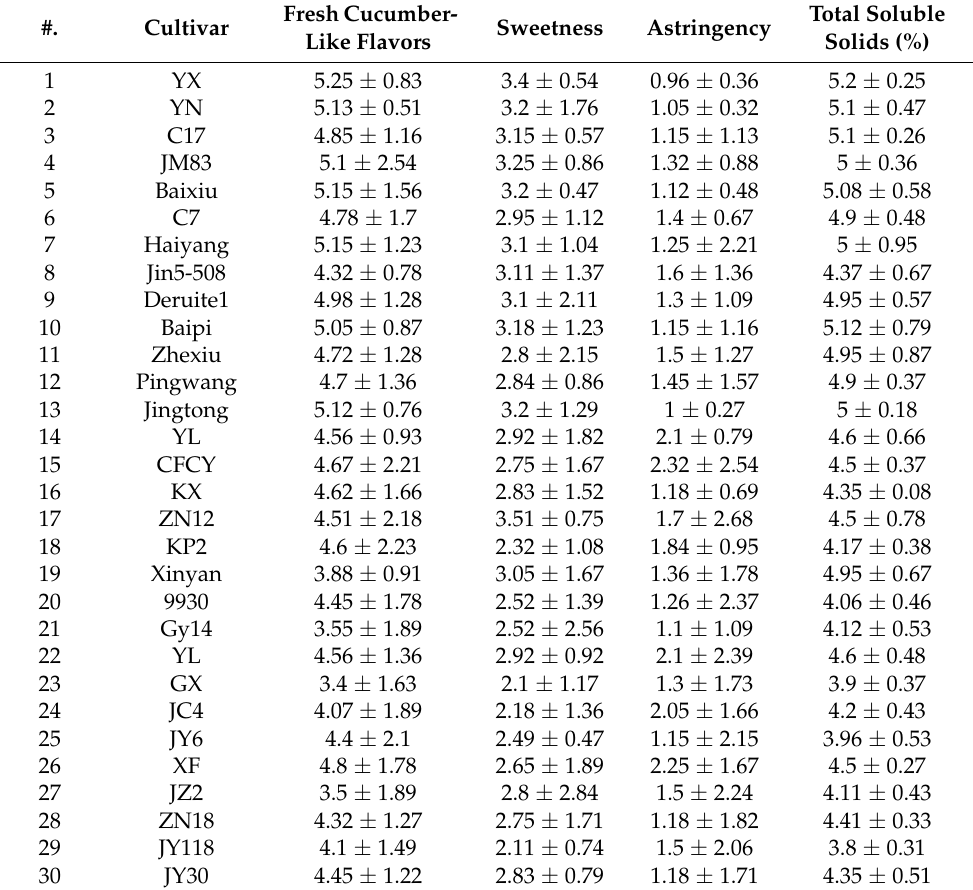
Table 1. Flavor quality evaluation of 30 cucumber cultivars.